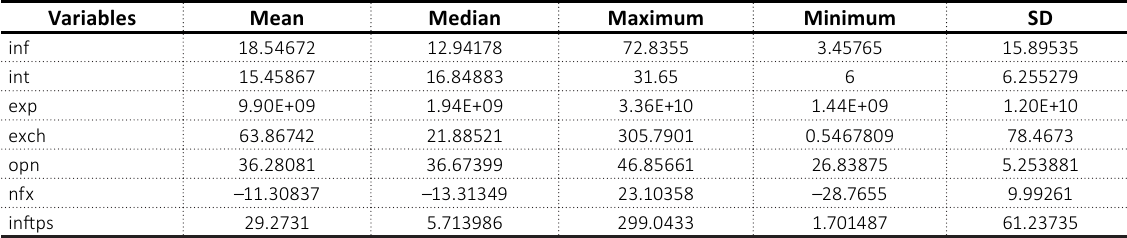
Table 2. Summary